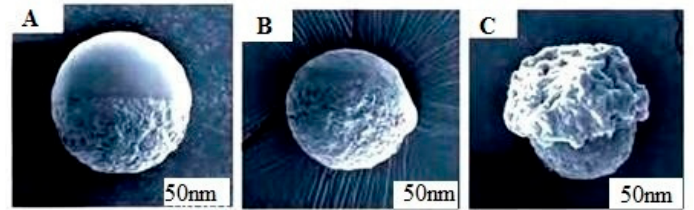
Figure 18. Electron Microscopic Scanning Image of Asymmetric Janus Nanoparticles Microcapsule Release. ( A ): at room temperature; ( B ): at 35 °C; ( C ): temperature exceeds 45 °C